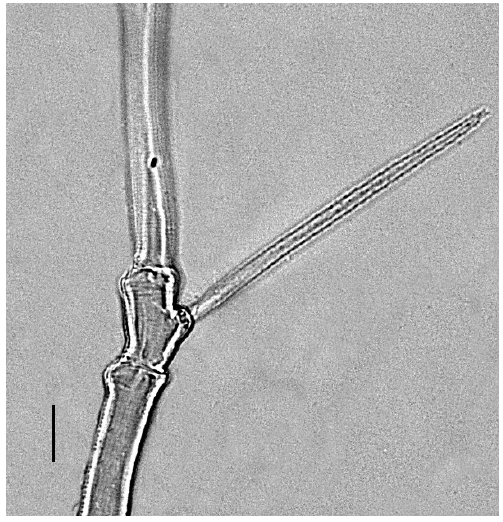
Figure 25. Neophyllobius muscantribii . Female. Genu IV. Scale bar: 50 μ m.